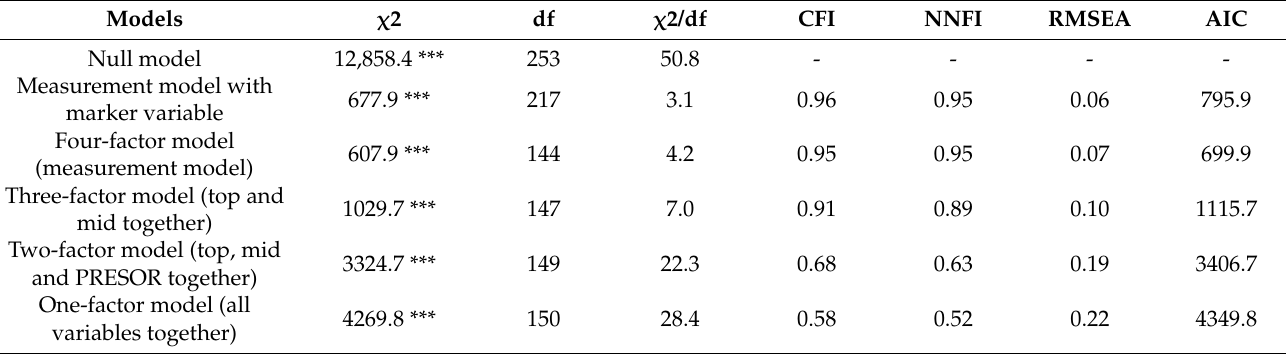
Table 2. Results of Model Comparisons (N =